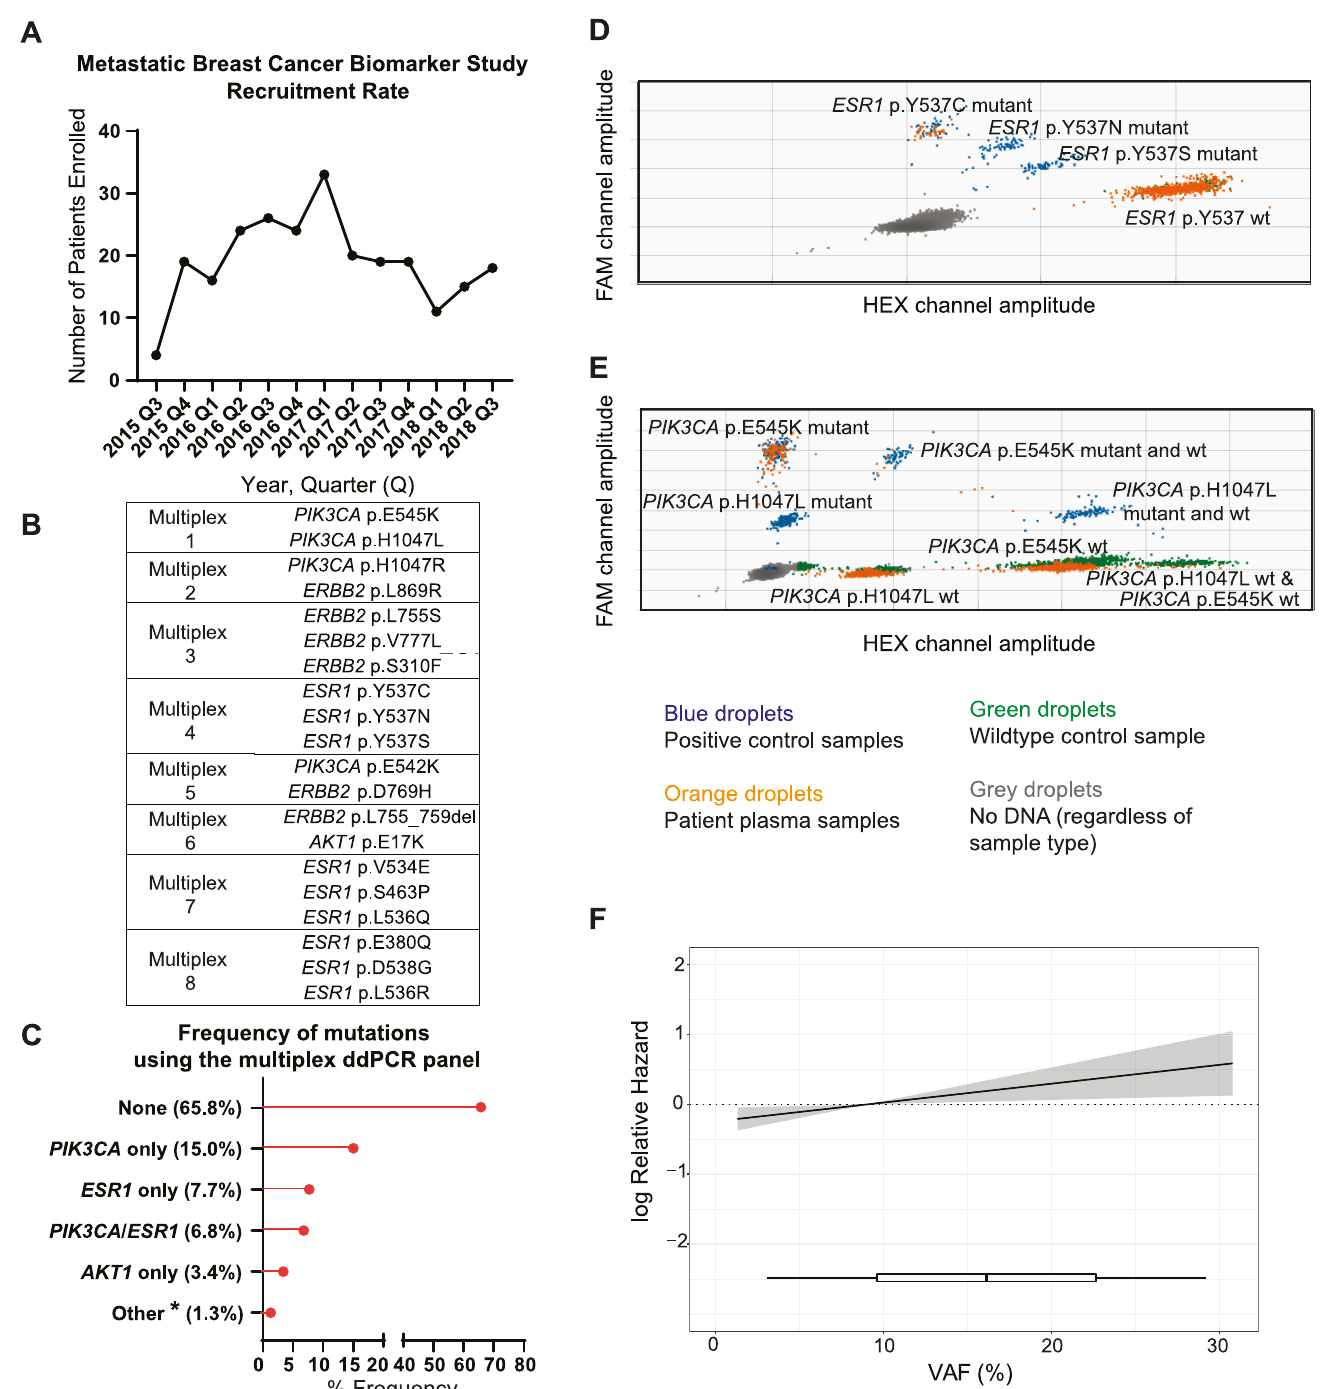
Fig 2. Patient recruitment and multiplex ddPCR testing of plasma samples at baseline. (A) Recruitment rate of patients on the MBCB study. (B) Layout of the multiplex ddPCR panel with 20 mutation-specific probes combined over 8 different reactions. (C) Frequency of mutations identified at baseline using the multiplex ddPCR panel in the 234 patients of the MBCB cohort. � One patient had both an ESR1 and AKT1 mutation detected; 1 patient had both a PIK3CA and ERBB2 mutation detected; and 1 patient had an ERBB2 mutation detected only. (D-E) Examples of the detection of specific mutations via the multiplex ddPCR assay using QuantaSoft software. (D) Results of multiplex reaction 4 show detection of the ESR1 p.Y537C mutation in patient MBCB134, and (E) results of multiplex reaction 1 show detection of the PIK3CA p.E545K mutation in patient MBCB155. Orange droplets correspond to patient plasma samples (detected by either mutation [FAM]/wt probe [HEX] as